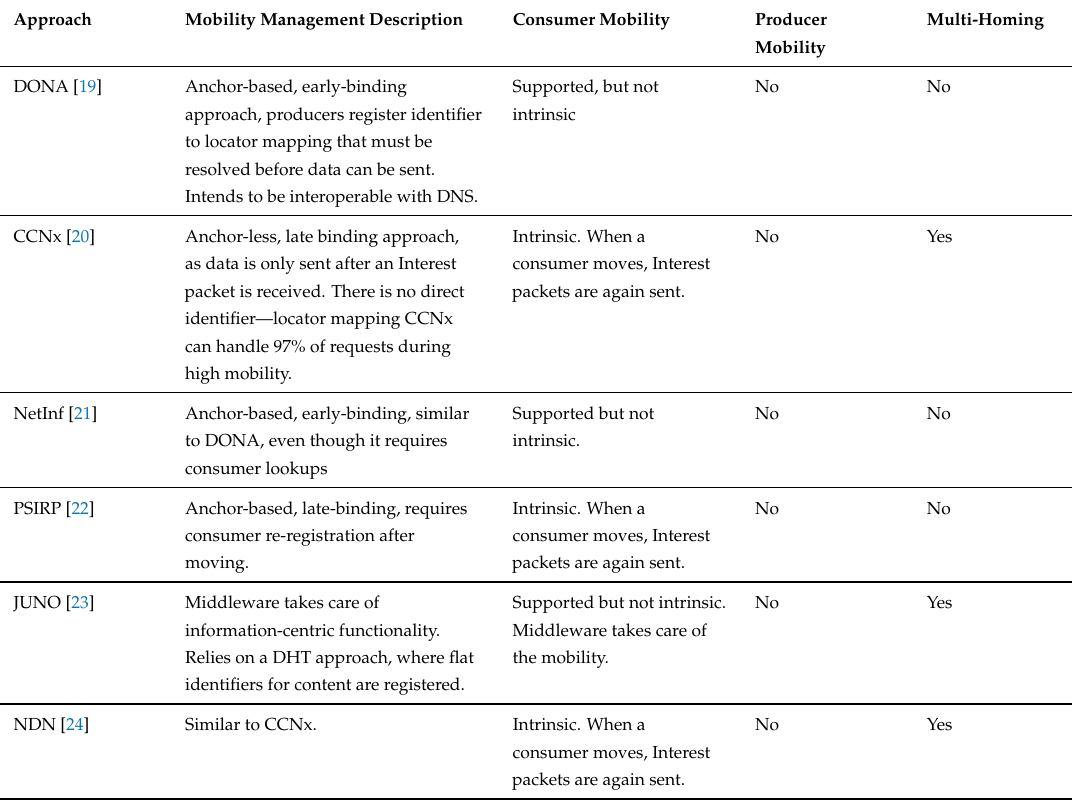
Table 2. ICN main approaches, mobility